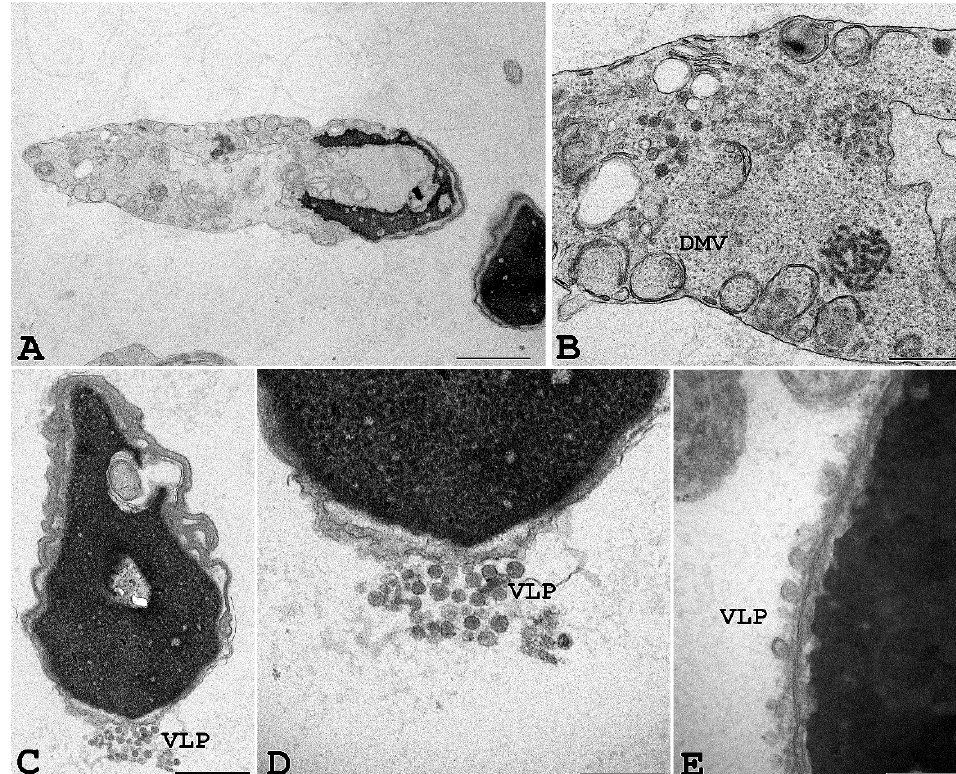
Figure 6. Ejaculated human sperm infected in vitro with SARS-CoV-2. Viral-like particles (VLP) and double-membrane vesicles (DMV) are seen in the sperm, particularly in cytoplasmic residues embedding the sperm head and/or tail. Scale bar: ( A ) and ( D ) = 1 µm; ( B ) = 2 µm, ( C ) = 0.5 µm; ( E ) = 0.2 µm.